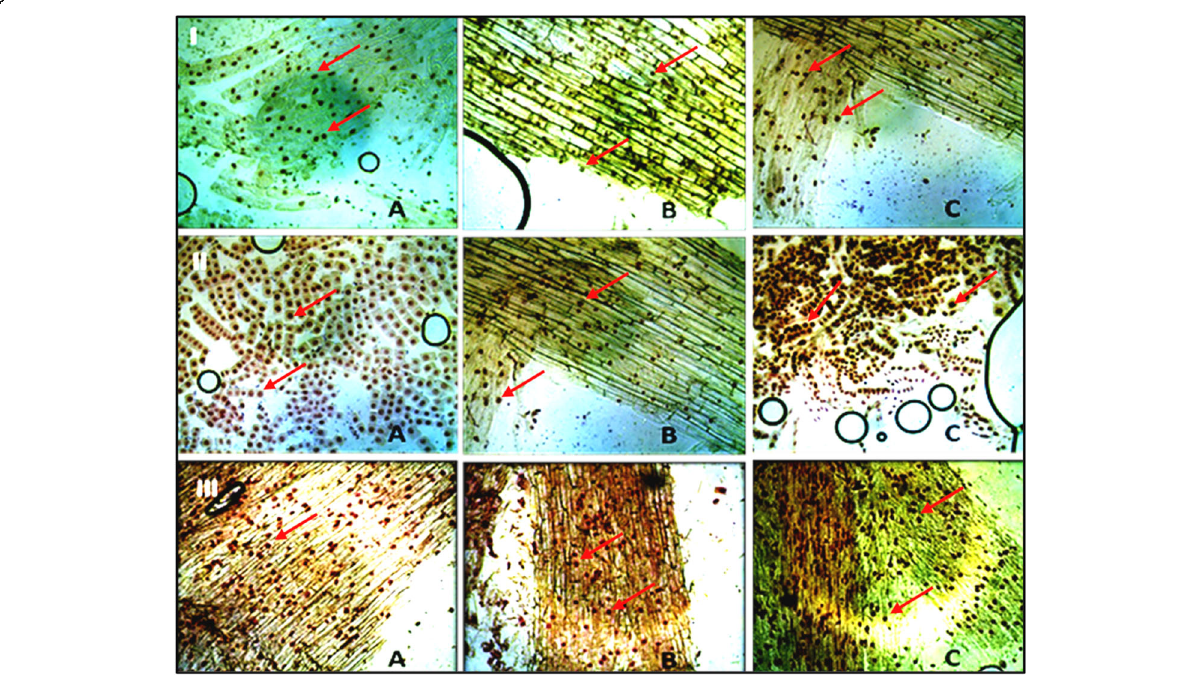
Fig. 2 Microscopic observation at 10× magnification of Allium cepa meristematic cells treated with (A) water, (B) methotrexate (standard) and (C) plant extract: (I) M. pruriens , (II) A. longifolia and (III) S. indicus. Arrows showing dividing